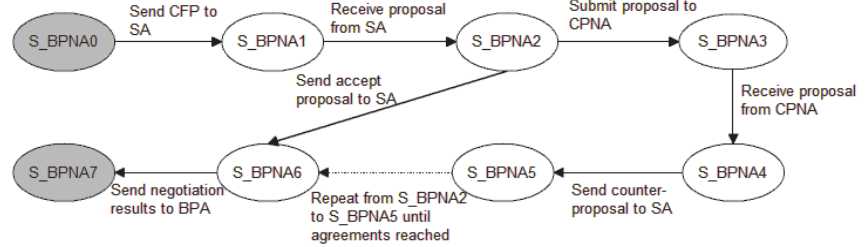
Fig. 6. State transition diagram of the BPNA